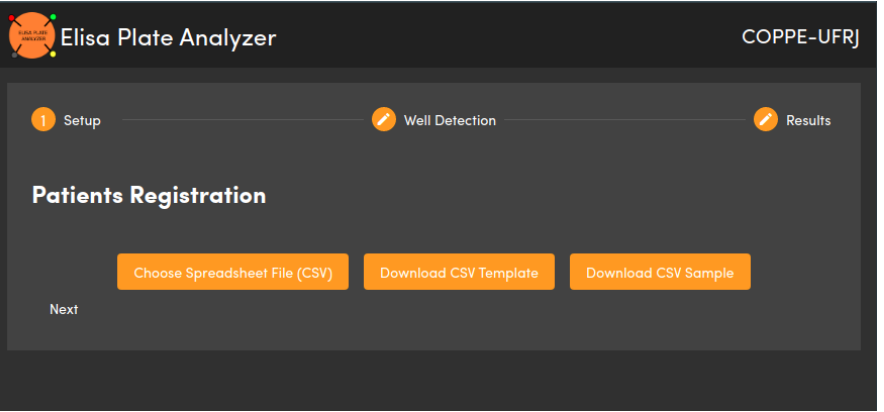
Figure 10. Setup step in the ELISA Plate Analyzer